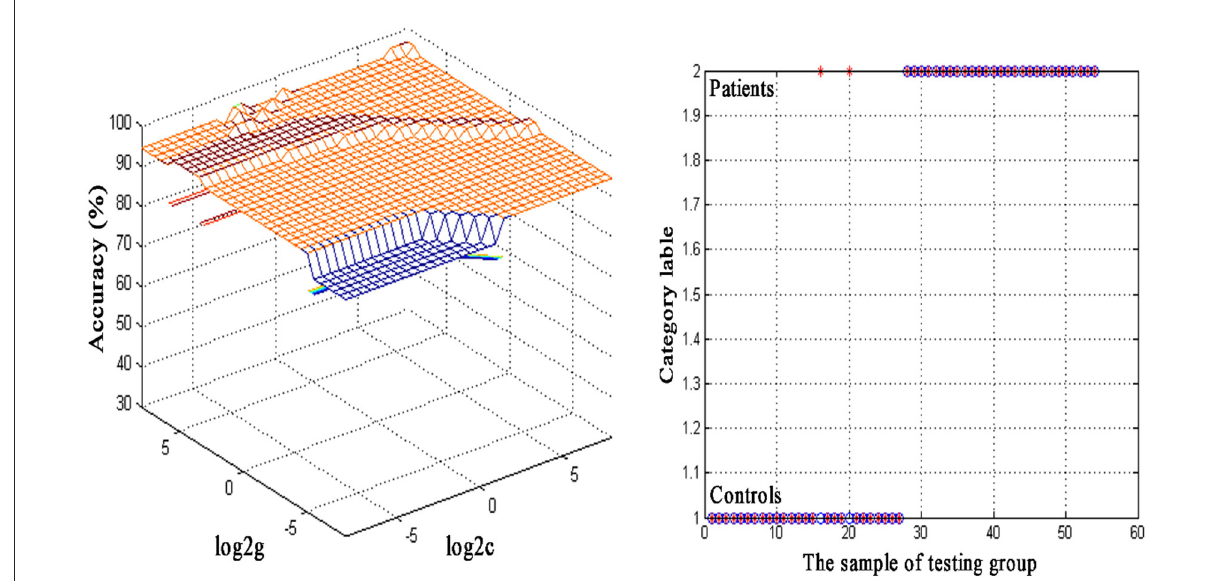
FIGURE2 Visualization of classifications through support vector machine (SVM) using the decreased regional homogeneity (ReHo) values in the left cerebellum to discriminate SSNHL patients from normal controls. Left: SVM parameters result of 3D view. g means gamma, c means penalty coefficient. Right: Classified map of the ReHo values in the left cerebellum. Blue circle means true value and the red asterisk means predict value.